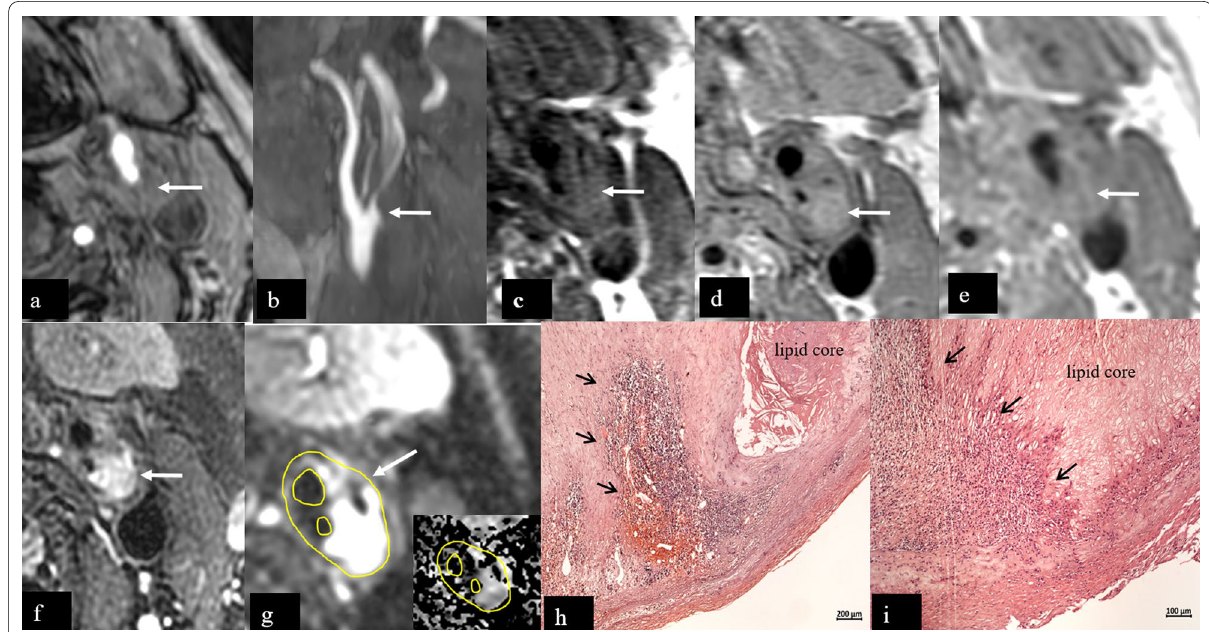
Fig. 2 Carotid MR images of a 66-year hypertensive female with left ICA stenosis detected following right upper limb paresis. TOF images ( a , b ) showed mildly hyperintense plaque (arrows) involving carotid bulbs extending into the proximal left ICA causing ~ 80% stenosis. T1 image ( c ) showed the plaque to have iso-hyperintense areas, which showed hyperintensity in PD ( d ) compared to T2 ( e ), suggesting lipid-rich plaque. The plaque, as identified better in a T2 FS ( f ) image, showed hyperintense areas in and DWI ( g ) with an ADC value (inset, g ) of 0.41 x 10 -3 mm 2 /sec. Post endarterectomy, histopathological analysis ( h , i ) showed necrotic lipid core with inflammatory cell infiltrate (arrows in h - Haematoxylin and Eosin, original magnification 50X, Scale bar 200 μm, i - Original magnification 100X, Scale bar 100